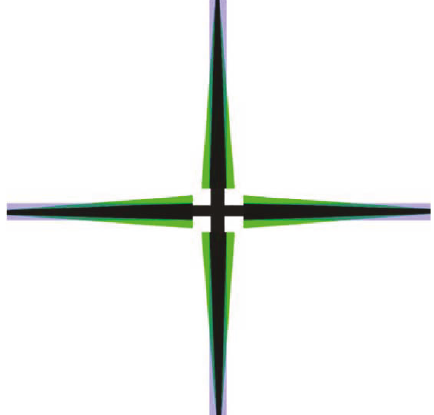
Figure 5: Illustration of variation in both blade taper and blade root chord (i.e., purple: original blade; black: tapered blade; green: both tapered and root chord-varied